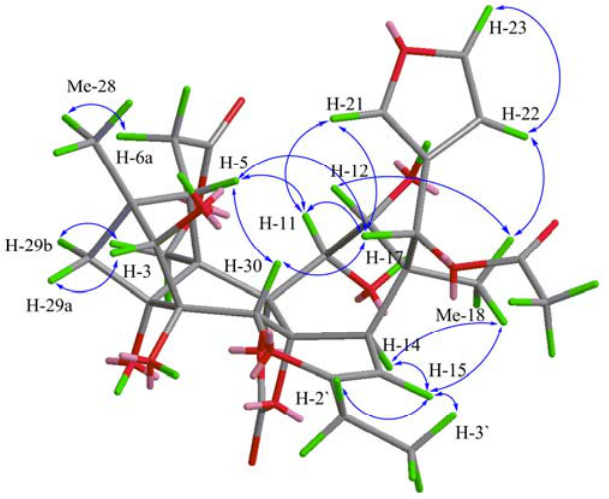
Figure 3. Key ROESY correlations of compound 1